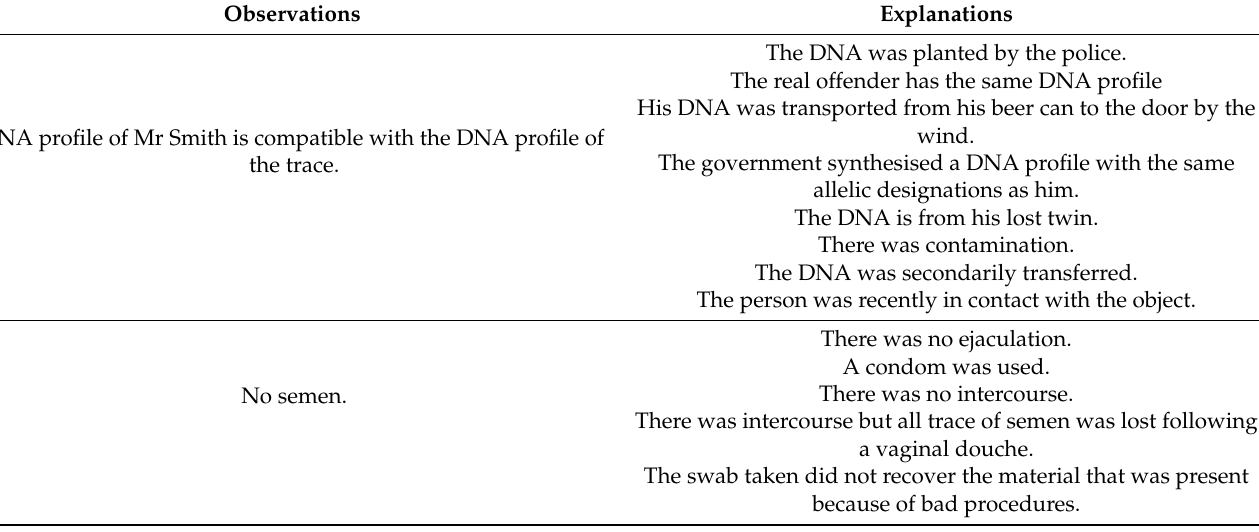
Table 7. Examples of explanations that can be given as investigative opinions, but not evaluative. Observations Explanations